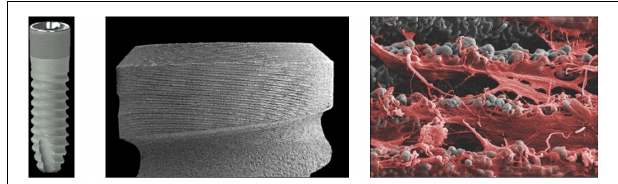
FIGURE 5 | Surface features and scanning electron micrographs of a Laser-Lok dental implant surface.